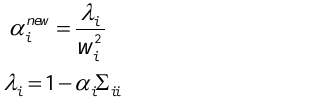
Figure 1. The image of 10 th band